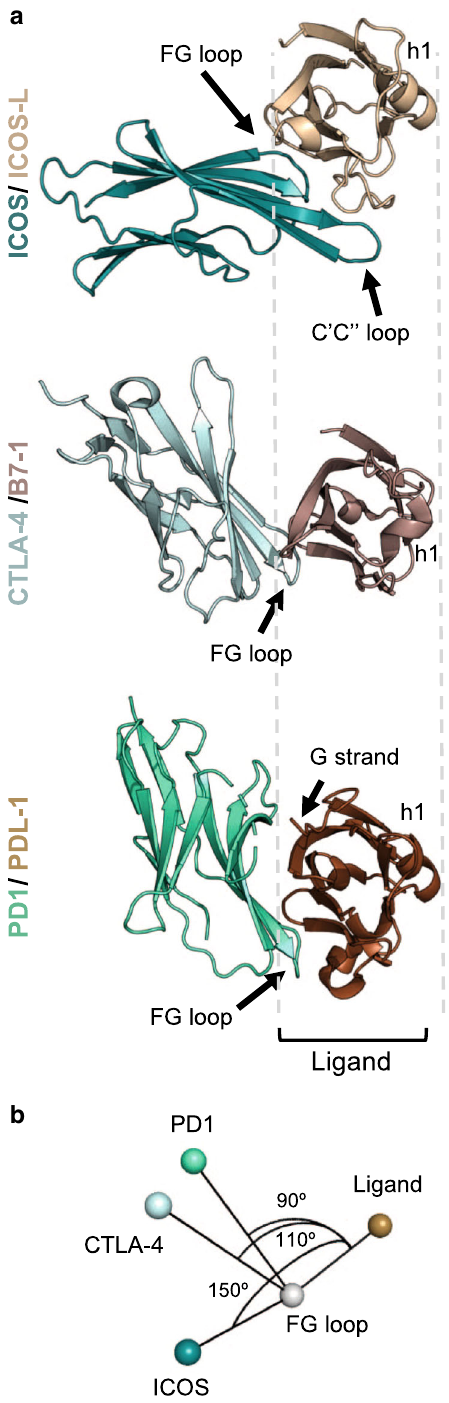
Fig. 2 Angle of ligand-receptor interactions for CTLA-4/B7 family members. a Top view cartoon representation of ICOS/ICOS-L and previously solved CTLA-4/B7-1 33 and PD1/PDL-1 69 complexes. The orientation of the complexes are based on the structural alignment of the ligands (different shades of brown). Receptors are shown as shades of green. Structural features are labeled to help with orientation. b Angle of approach of the three receptors to its ligands calculated using Pymol 70